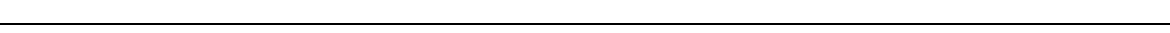
Fig. 5 Role of H3.3 in various induced cell fate changes. a Schematics of the transdifferentiation process indicating the time-points at which chromatin was collected for preparing H3.3 ChIP-Seq libraries. b Venn diagram revealing the number of uniquely and commonly bound genes among day 0 H3.3, day 4 H3.3 and iHP H3.3. c Bar chart revealing the signi fi cantly enriched biological processes for genes which are bound by H3.3 on day 4 and in iHP (dark grey) and those bound by H3.3 at day 0 and day 4 (orange). X -axis represents the enrichment score of the hypergeometric enrichment test. d Schematics of the knockdown experiment (top). The bar charts below represent the number of cobblestones formed (left) and CFU numbers (right), observed in wells in which the knockdown of the H3.3 had been performed. Non-targeting siRNA constructs (siNT) were used as controls. The images above the bar charts are representative images of the wells in which the counting took place. Scale bars equal 100 µ m. Values are mean ± s.e.m from independent replicate experiments ( n = 3). Two-tailed t -test was used for statistical analysis. Error bars represent standard deviation. e Bar chart demonstrating the level of expression of the indicated genes at day 1 and day 2 of the induced neuronal differentiation after the knockdown of H3.3 (si H3.3 ). Non-targeting siRNA (siNT) were used as controls. Y -axis represents the fold change over control sample. * p -value <0.05. Two-tailed t -test was used for statistical analysis. Error bars represent standard deviation ( n = 3). f Bar chart demonstrating the level of expression of the indicated genes at day 4 and day 6 of the induced differentiation to neuronal lineage after the knockdown of H3.3 (si H3.3 ). Non-targeting siRNA (siNT) were used as controls. Y -axis represents the fold change over control sample. * p -value <0.05. Two-tailed t -test was used for statistical analysis. Error bars represent standard deviation ( n =